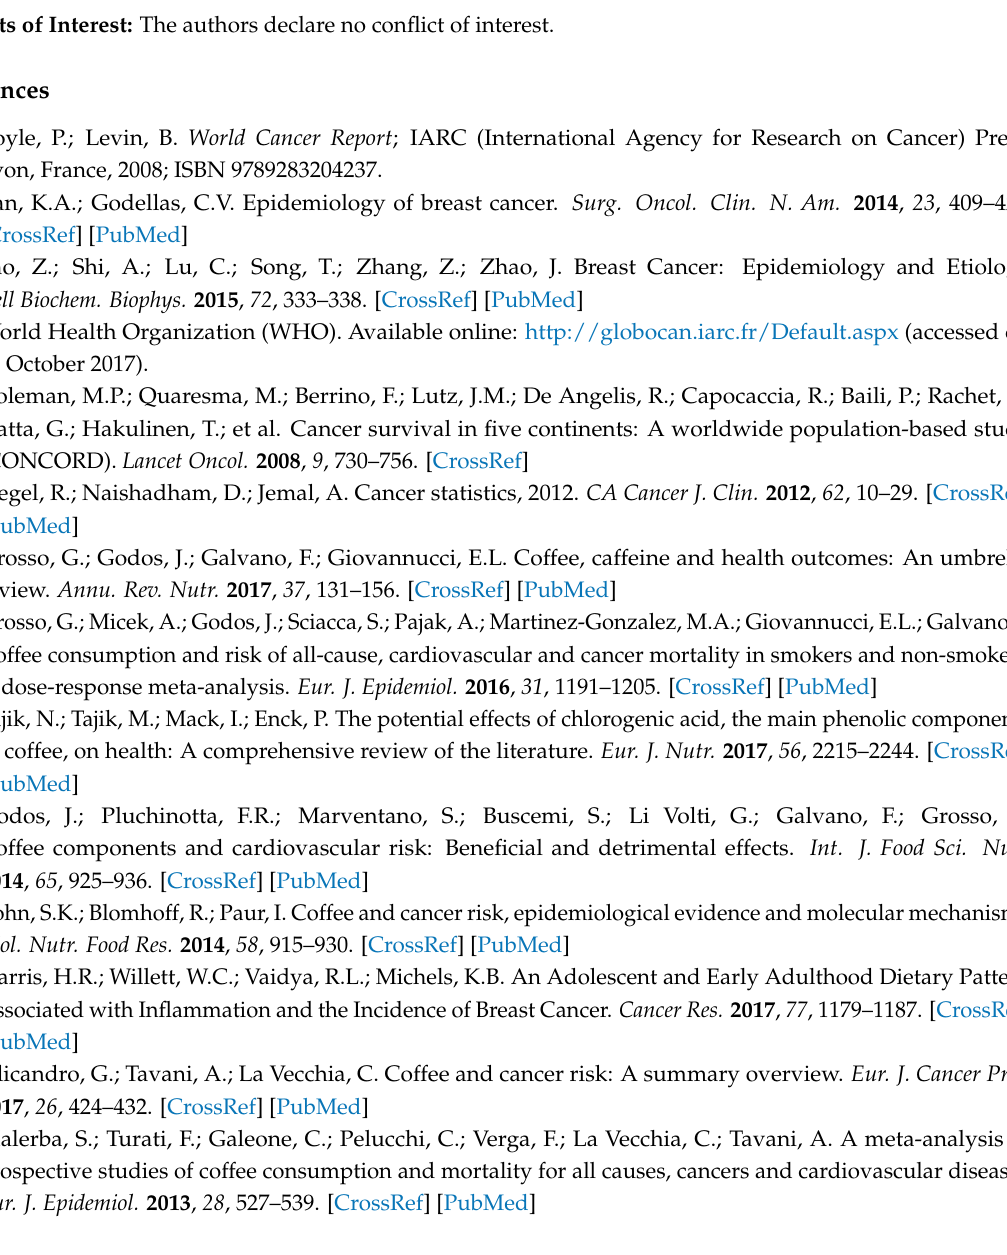
Table S1: Meta-Analysis of Observational Studies in Epidemiology (MOOSE) checklist, Table S2: Search